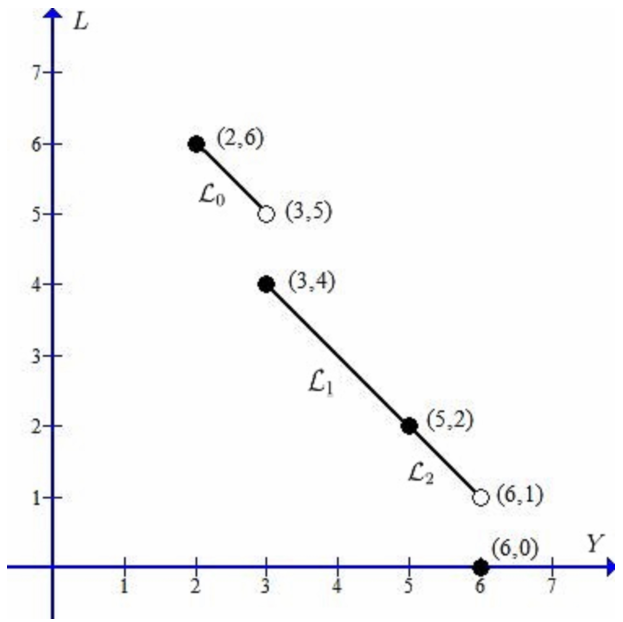
Figure 2. Trade-off